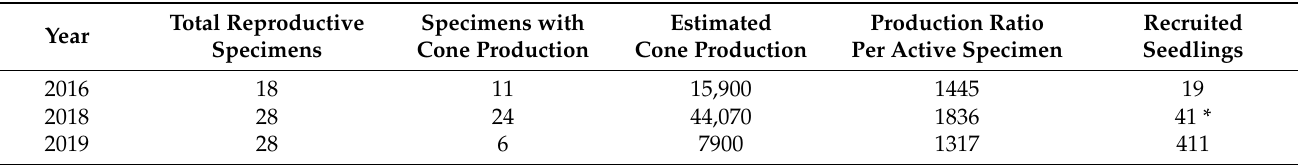
Table 3. Observed changes in the main reproductive parameters. * Among these specimens, 11 were from 2017 and 30 from 2018.